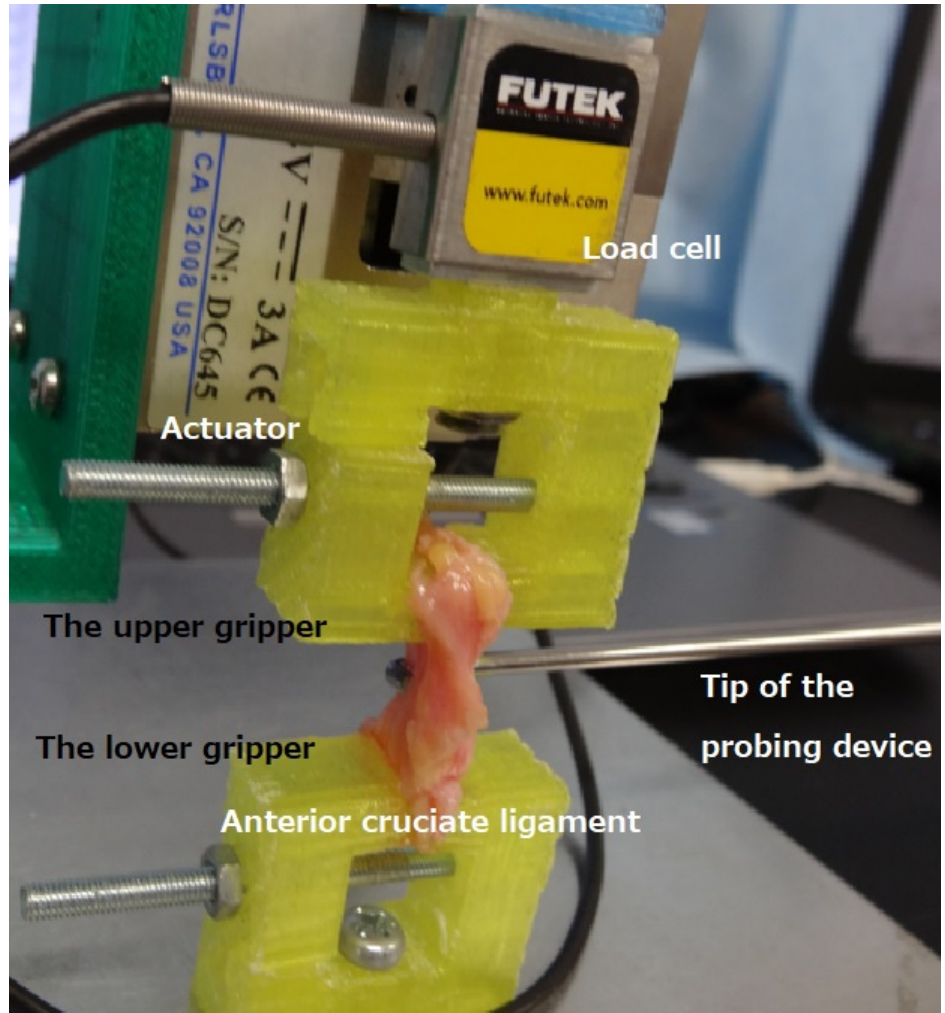
Figure 1. The tensile tester used in this study was an in-house-developed benchtop uniaxial loading device. Immediately after tension, pull probing horizontally to the anterior cruciate ligament speci- men was performed using the probing